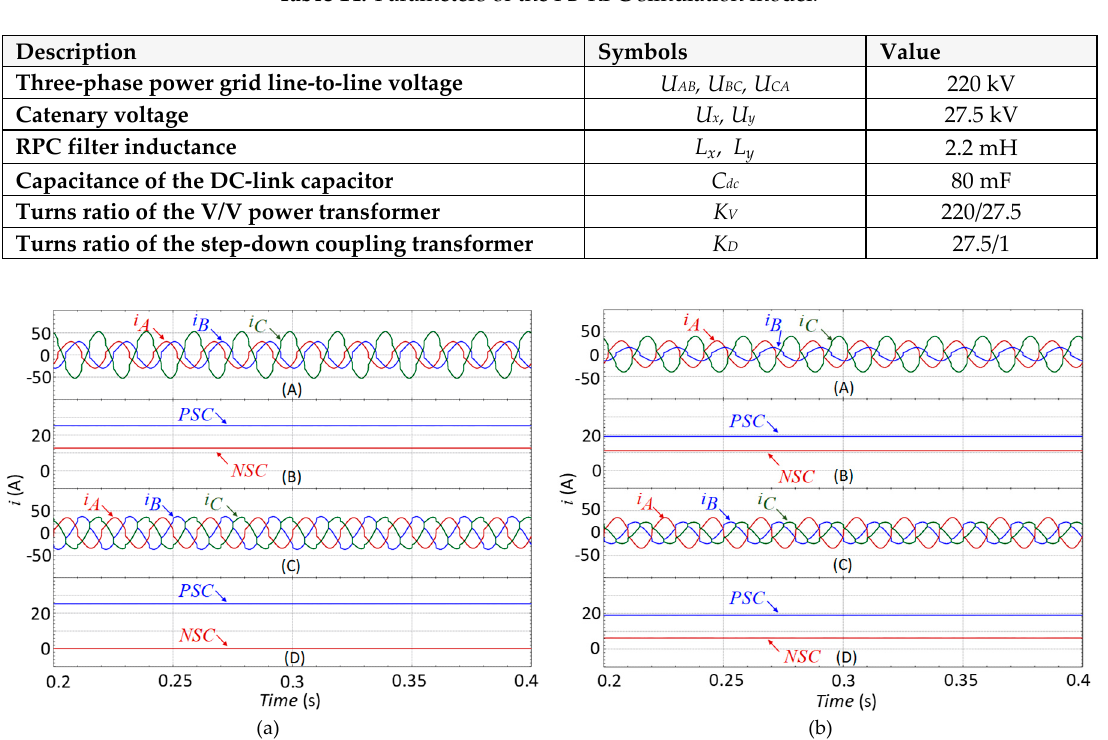
Figure 20. Three-phase power grid currents, PSC, and NSC of currents in V/V and Scott traction power systems: when the feeder sections are equally loaded ( a ); and when the feeder section x has double the load of the feeder section y ( b ) ( ( A,B) when using the V/V traction power system; and ( C,D) when using the Scott traction power system).